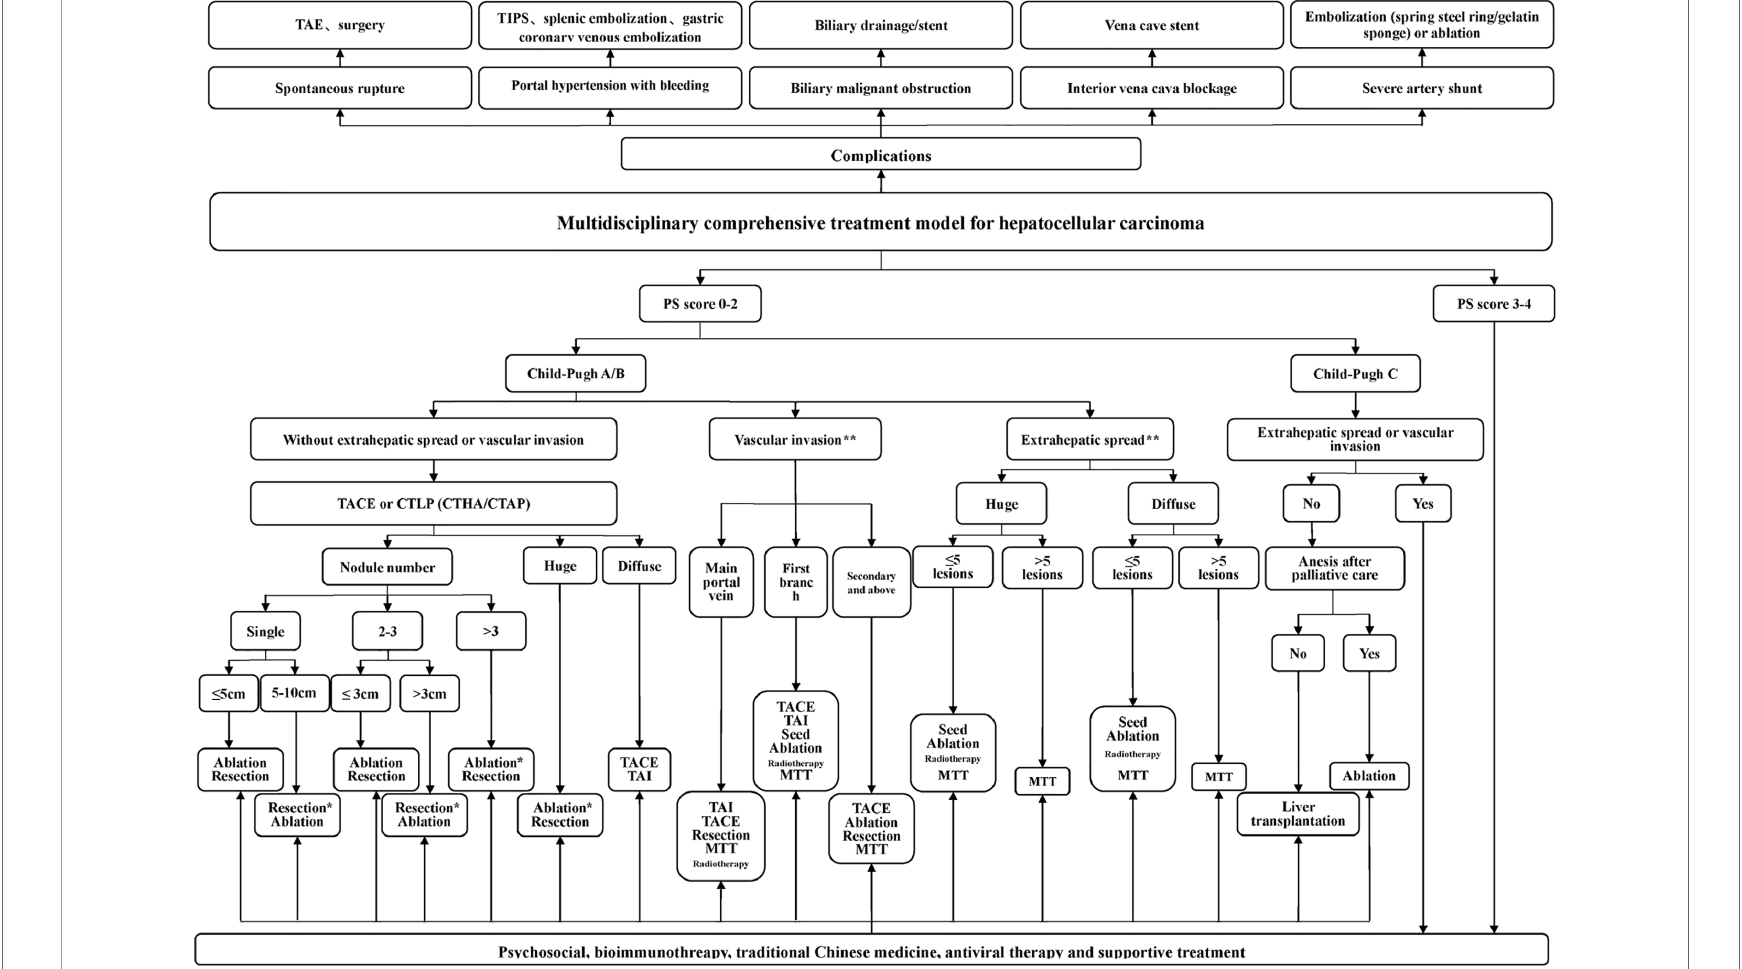
FIGURE 2 | Multidisciplinary, comprehensive treatment model. TIPS: transjugular intrahepatic portosystemic shunt; PS (performance status) score: systemic condition test score; Massive type: maximum tumor diameter > 10 cm; Diffuse type: extensive and diffusely distributed intrahepatic cancer lesions with unclear borders, often accompanied by cirrhosis; Ablation: RFA, MWA, and PEI, among others, but primarily RFA and MWA; *Ef fi cacy comparison of surgery and TACE combined with ablation awaits con fi rmation in further randomized multicenter clinical studies. **Treatment of portal vein invasion and extrahepatic metastasis should be based on control of intrahepatic lesions, which mostly requires multidisciplinary, comprehensive treatment. 1. Tumors in the safe area are preferably ablated. When a tumor is in a dangerous area and is not suitable for ablation, surgery is considered. 2. Ablation treatment can be repeated. For a tumor that is dif fi cult to ablate in one treatment, the residual portion can be ablated again after follow-up